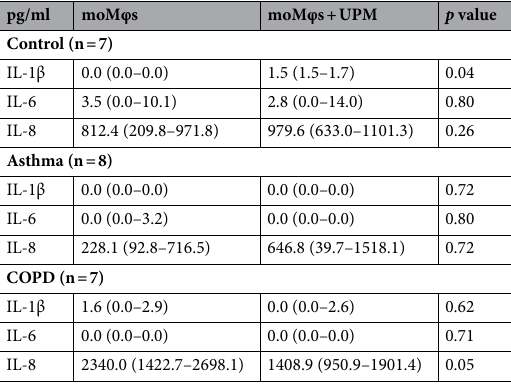
Table 4. The level of IL-1β, IL-6, IL-8, secreted by moMφs of control, asthma and COPD patients with and without UPM treatment. The results are presented as median and